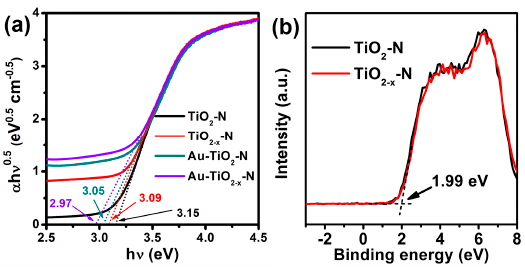
Figure 8. ( a ) The optical absorption edges and ( b ) XPS valence band spectra of various TiO 2 supports and Au ‐ TiO 2 catalysts.